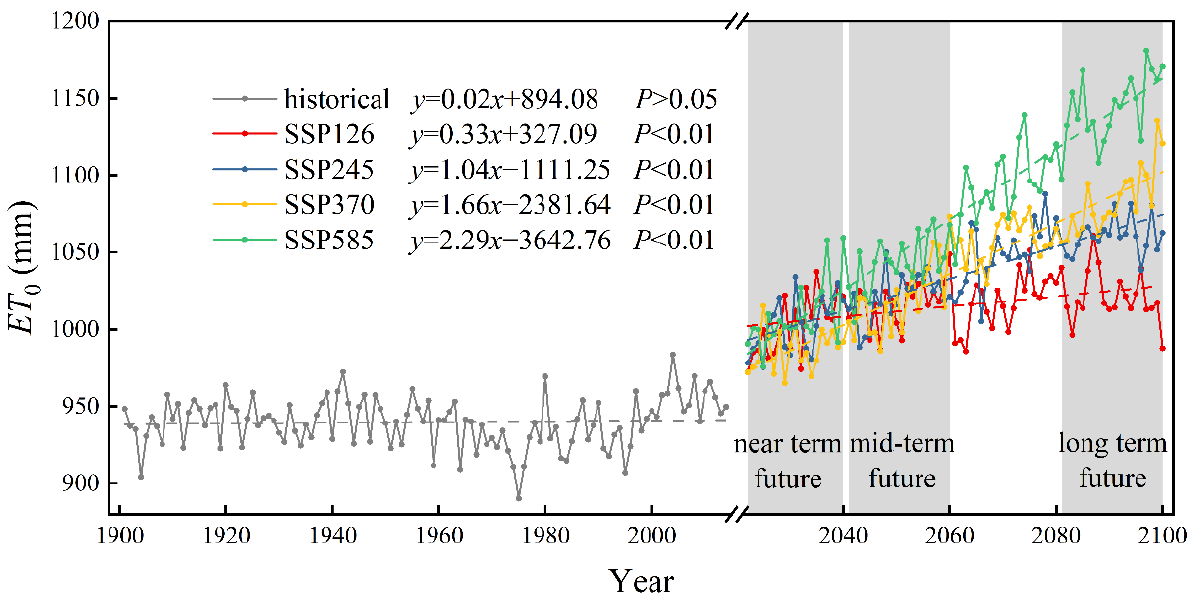
Figure 8. Interannual variations in ET 0 in the Yellow River Basin over the historical period (1901–2014) and under different future emission scenarios (2022–2100; SSP126, SSP245, SSP370, and SSP585) ( p is an indicator of significance obtained by the F-test).